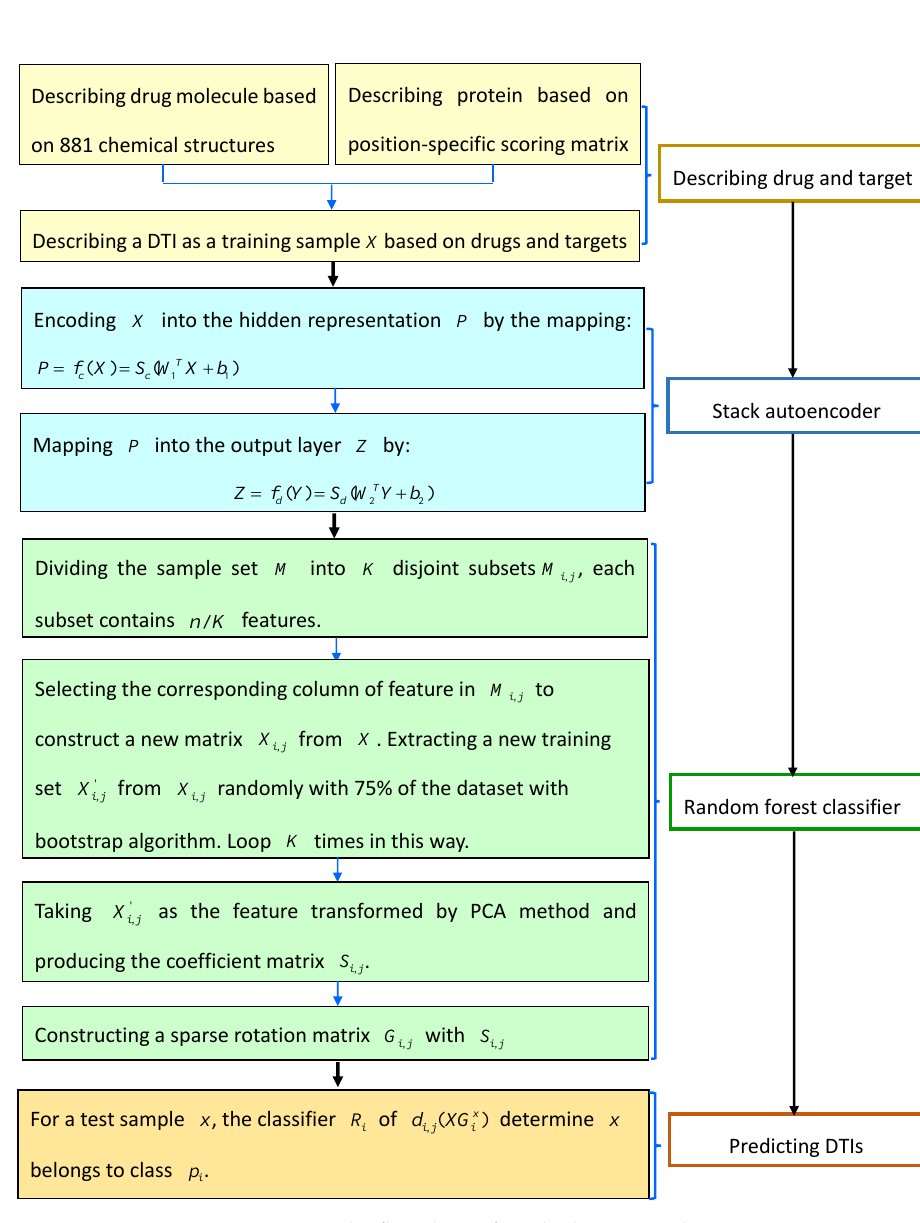
Figure 12. The flowchart of stacked